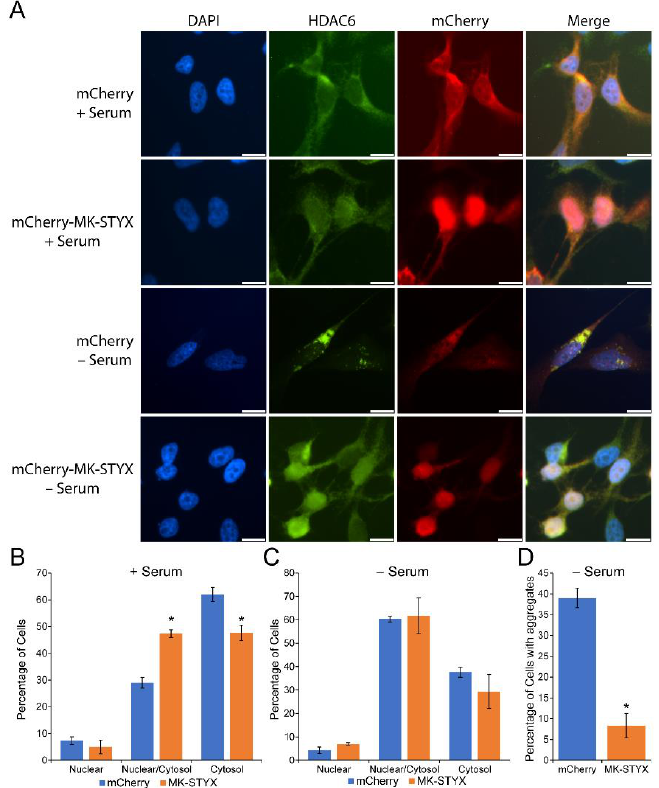
Figure 1. MAPK (mitogen-activated protein kinase)